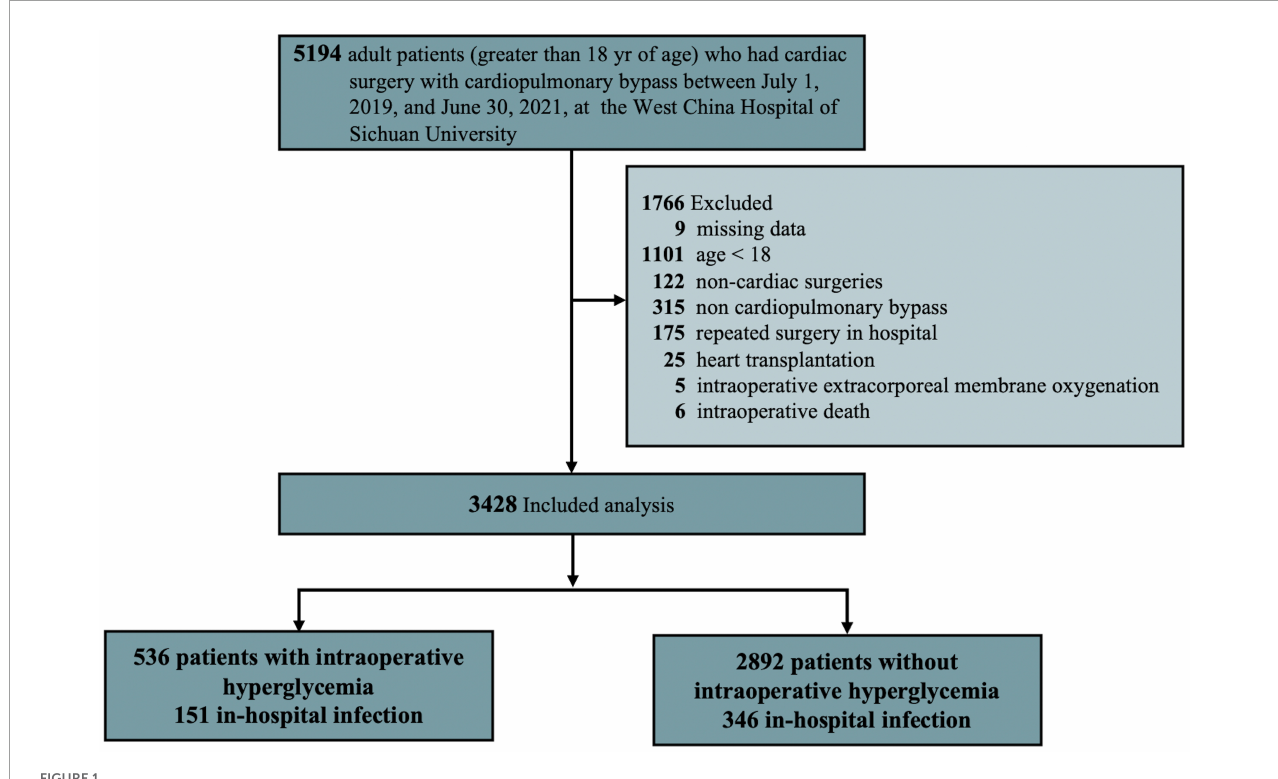
FIGURE1 Flow chart of patient